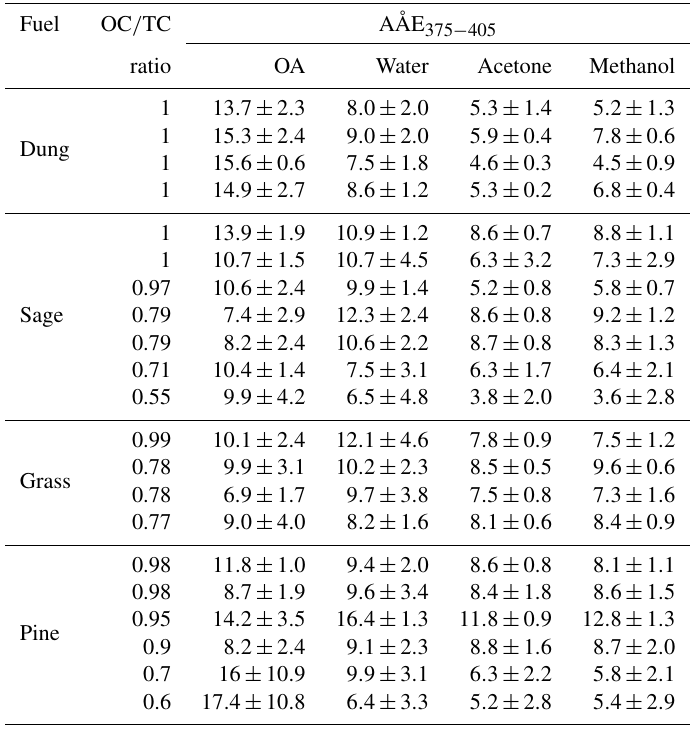
Table 4. The AÅE of OA (from various fuels) extracted in water, acetone, and methanol, alongside the AÅE measured from particle-phase b abs , OA .